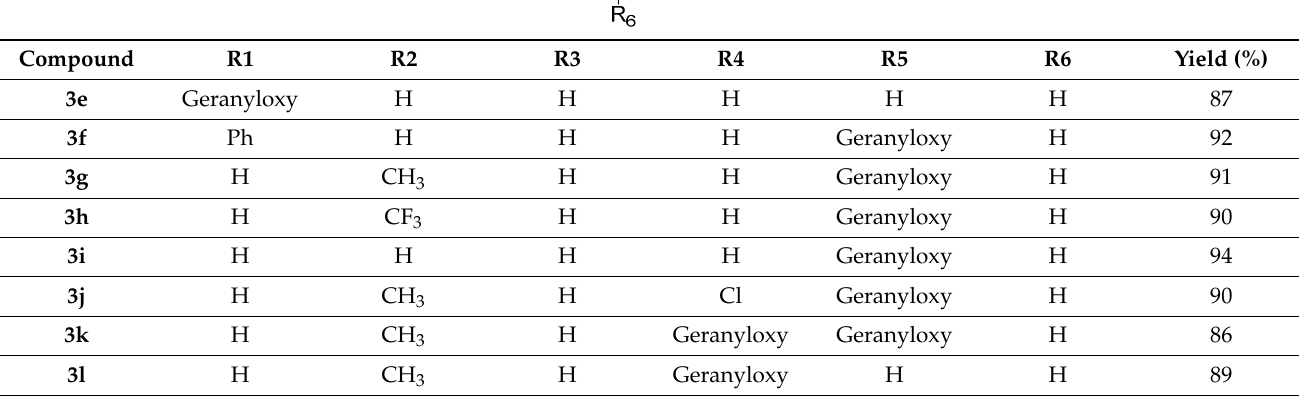
Table 2. Hydroxycoumarin derivatives with functional groups in several positions 1e – Table 1. Synthesized geranyloxy coumarin compounds 3e – 3l .